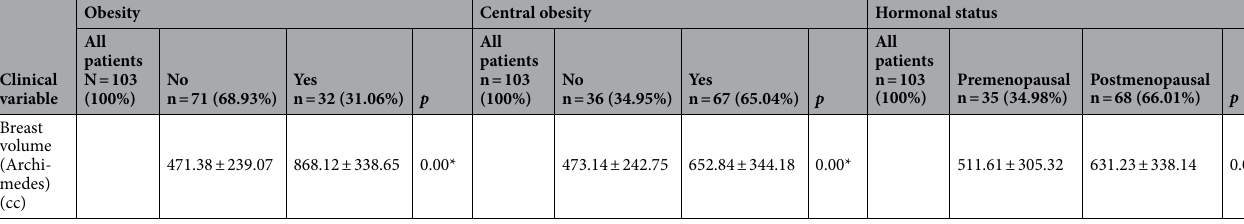
Table 3. Breast volume in breast cancer patients according to their BMI (obese vs. non-obese), to their WHR (< 0.85 vs ≥ 0.85) and to their hormonal status (pre- vs. postmenopausal). n = number of cases assessed for each variable. Data expressed as means ± standard deviation. * p < 0.005.